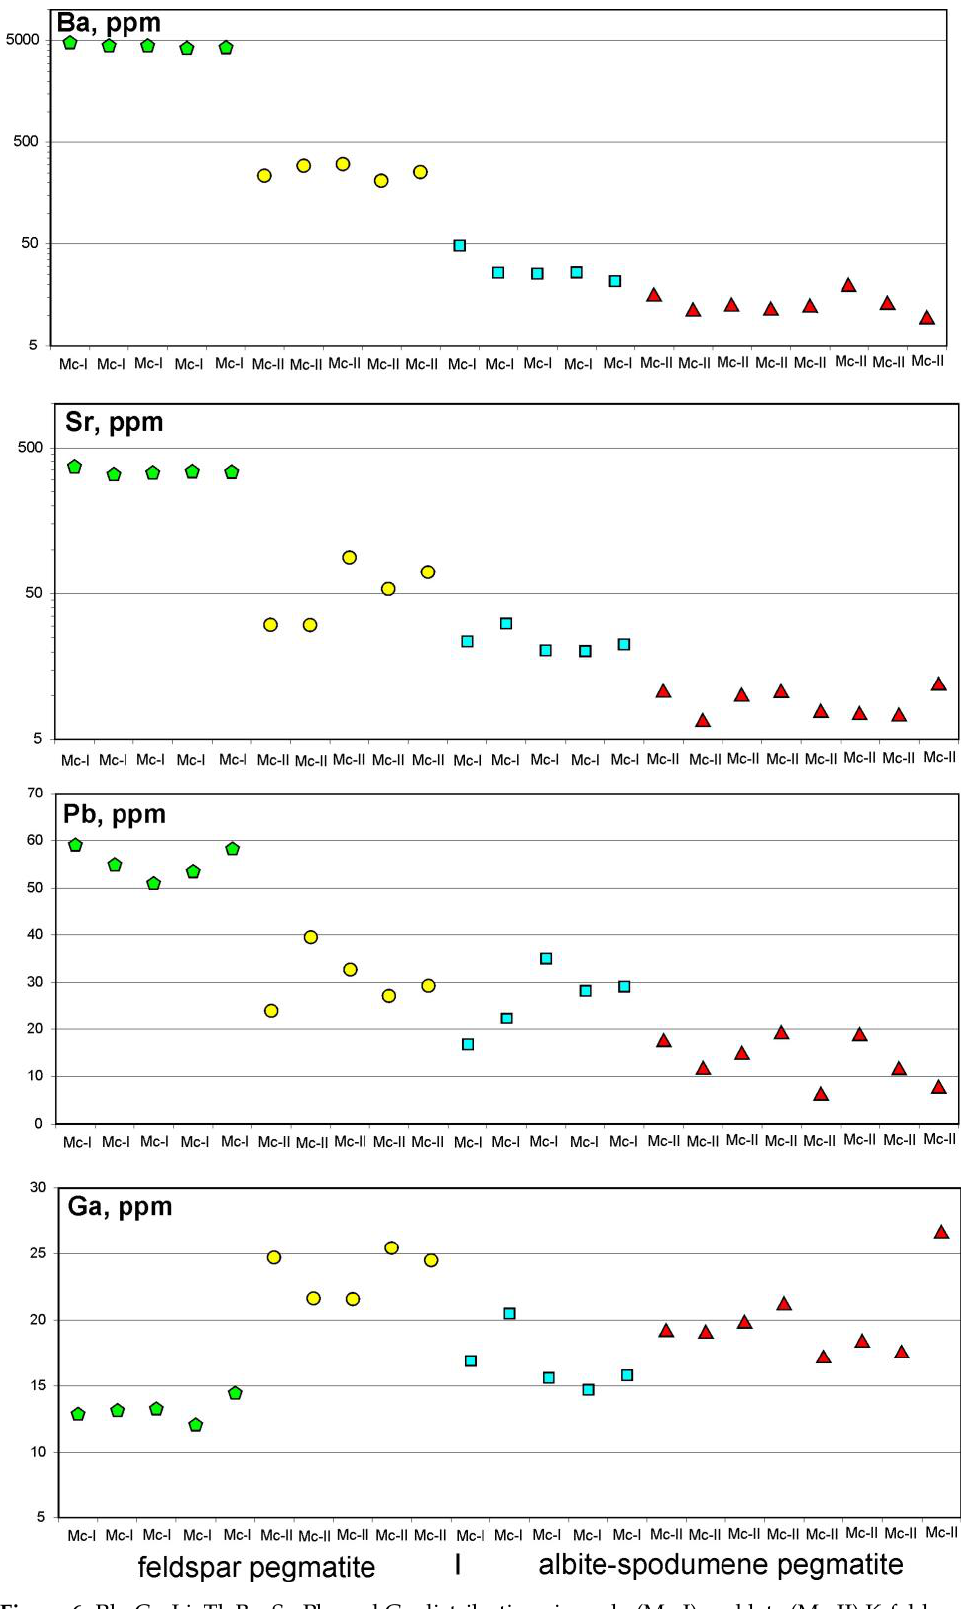
Figure 6. Rb, Cs, Li, Tl, Ba, Sr, Pb, and Ga distributions in early (Mc-I) and late (Mc-II) K-feldspars from feldspar and albite-spodumene pegmatites of the Kolmozero deposit. Albite-spodumene pegmatites: Mc-I (blue squares), Mc-II (red triangles). Feldspar pegmatites: Mc-I (green pentagons), Mc-II (yellow circles).